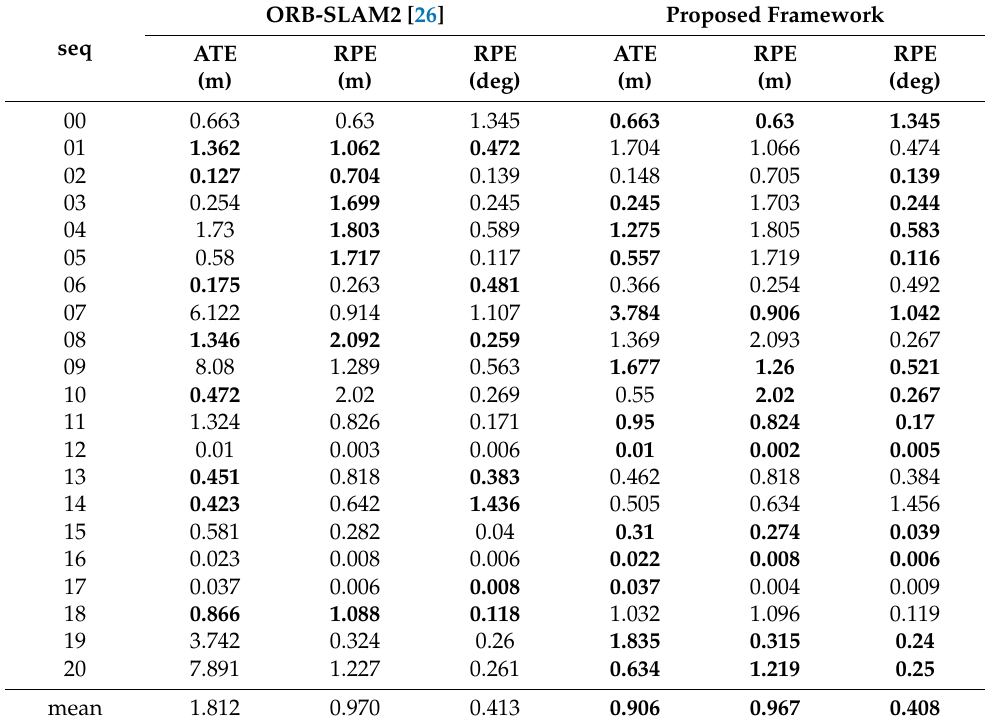
Table 1. The estimated trajectories evaluation and comparison on KITTI Tracking Datasets. ORB-SLAM2 [26] Proposed Framework seq